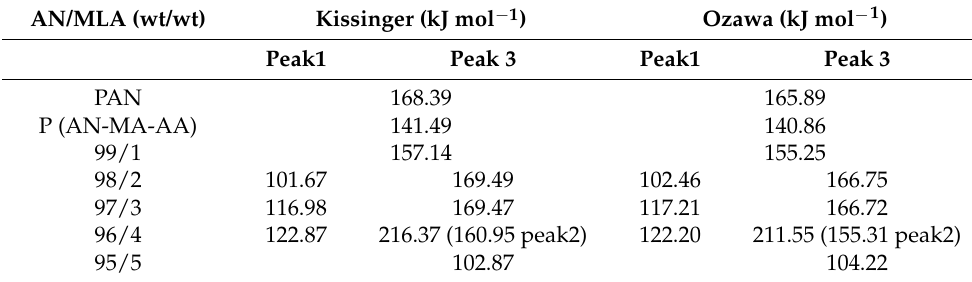
Table 7. Ea determined by Kissinger and Ozawa